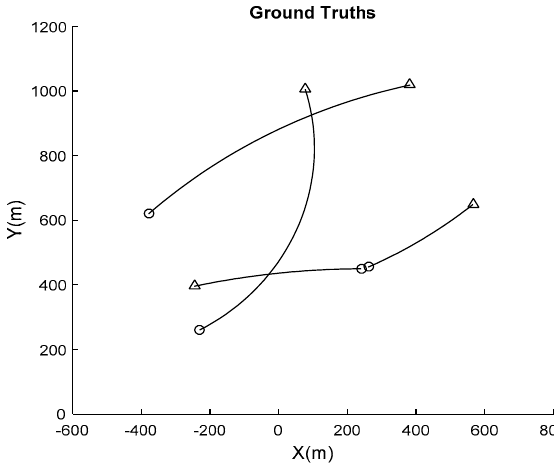
Figure 9. Trajectories of the targets.